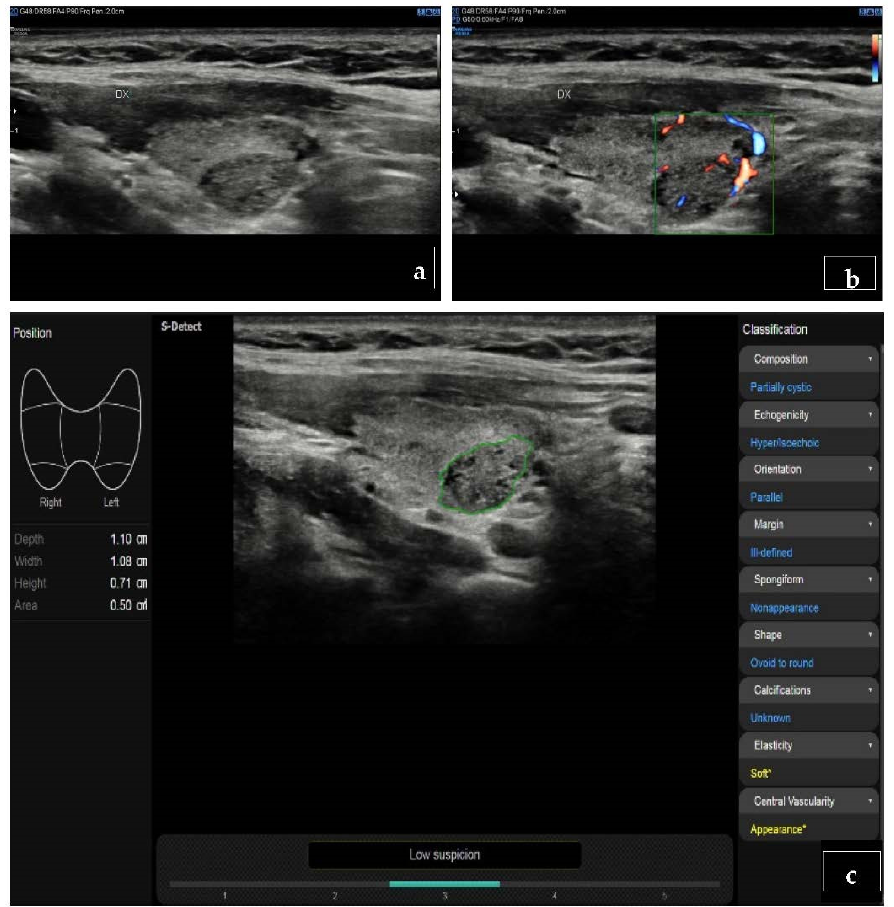
Figure 3. Histologically proved follicular hyperplasia. ( a ) The nodule appears iso-hypoechoic at B- mode. ( b ) At ColorDoppler-US evaluation, it shows type III vascular pattern (intra- and perinodular) ( c ) At S-detect software, the nodule is classified as low degree of suspicion (K-TIRADS 3).